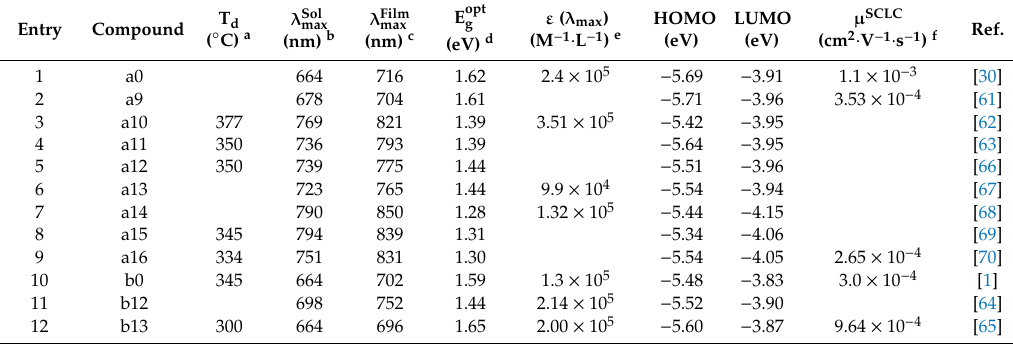
Table 5. Optical and electrochemical properties of acceptors a9–a12 and b12–b13.